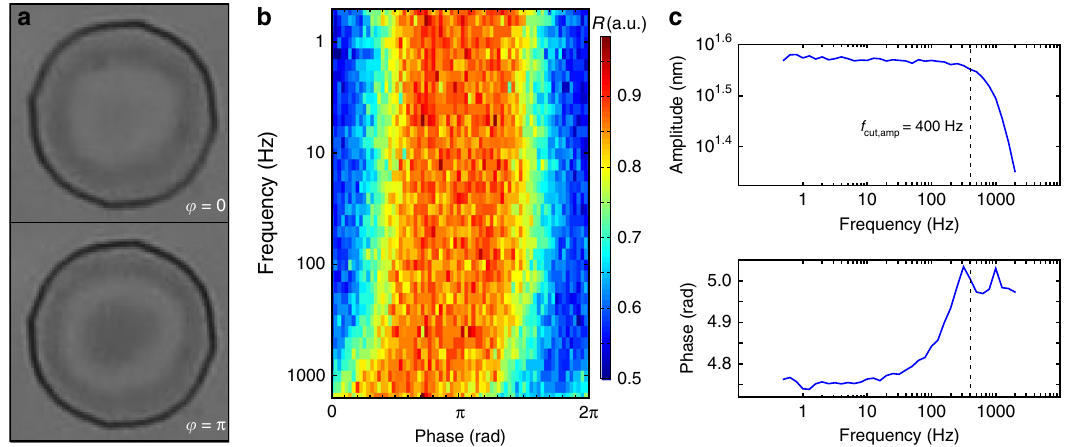
Fig. 3 Stroboscopic measurement. a Optical microscope image of a 15 μ m in diameter drum at two opposite phases of vibration ( ϕ = 0 top, ϕ = π bottom) while actuated at 1 kHz. b Color map of the re fl ectance at the center of the same drum as a function of frequency and phase. A phase delay intrinsic to the signal ampli fi er is observed. c Bode plots of amplitude and phase of the drum, showing that the response is fl at up to 400 Hz (cut-off frequency of ampli fi